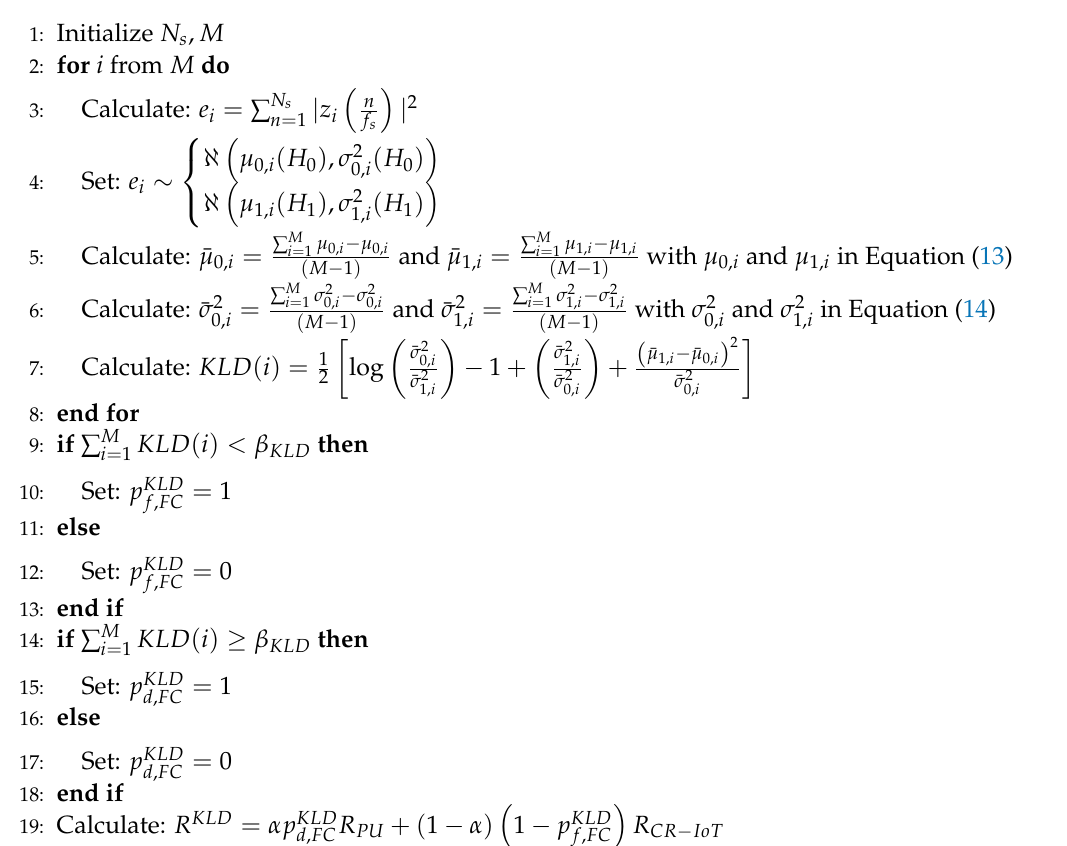
Algorithm 2 The proposed KLD technique for a CR-IoT network.